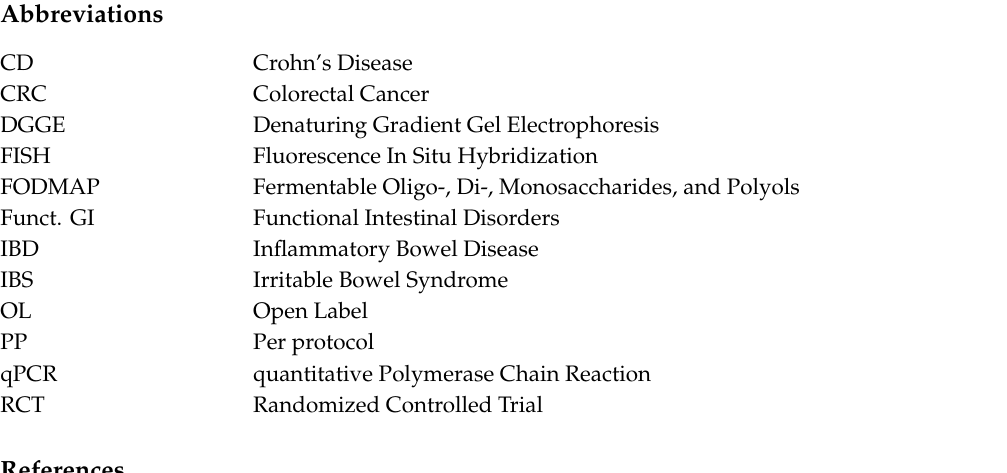
Table S1. Overview of studies and microbiome